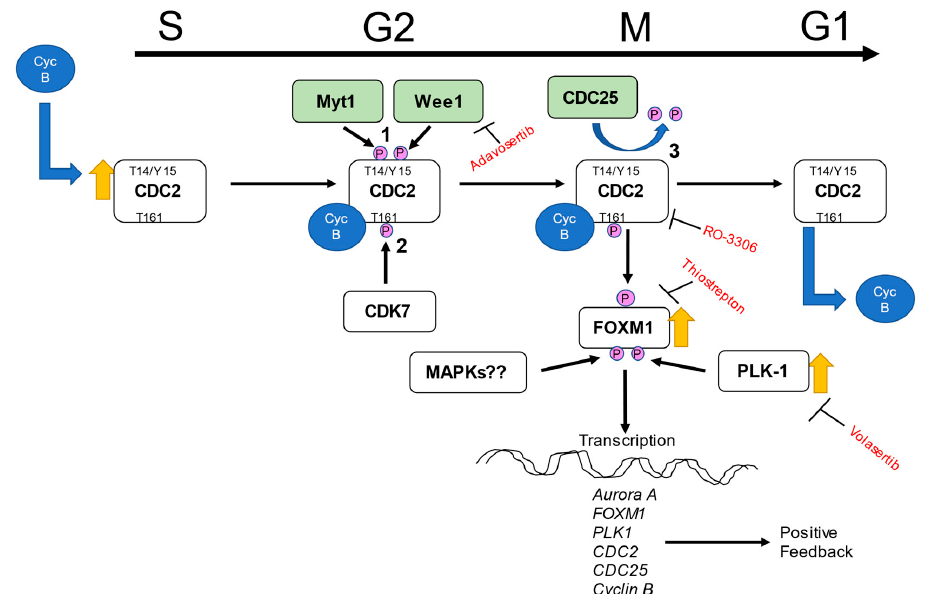
Figure 7. Hypothesized schematic of CDC2 signaling in PAH HPASMC. CDC2 complexed with cyclin B (Cyc B) is activated via a complex series of events which involve (1) Myt1 and Wee1 phosphorylating CDC2 at positions T14 and Y15 to protect CDC2 protein but keep it inactive, (2) CDK7 in G2 before mitosis phosphorylates at position T161 to initiate activation, and (3) CDC25 phosphatase removes phosphates at T14 and Y15 leaving CDC2 to be active in complex with cyclin B during mitosis where it phosphorylates and affects downstream targets. One target FOXM1 gets phosphorylated at positions T596 and S678 allowing for PLK1 binding. The binding of PLK1 leads to more phosphorylation of FOXM1 during G2/M transition and activation of FOXM1 and expression of mitotic genes leading to cell cycle progression. It is also possible that FOXM1/PLK1 might be activated independently by other molecules such as MAP kinases. The top black arrow indicates cell cycle phase at which occurrences take place.